Question: Briefly state, in one sentence, what is plotted here.
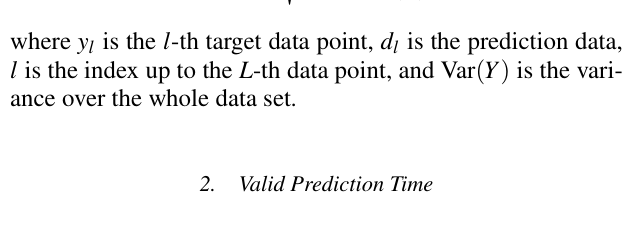
Answer: illustrates the closed-loop feedback configuration. In this setup, after the model has been trained, it is switched to a closed-loop mode, where the model’s own predictions are recursively fed back as input. This method allows for continu- ous predictions, extending beyond the one-step-ahead predic- tion. The quality of predictions in a closed-loop configuration is evaluated by a metric called the valid prediction time (VPT) [28], defined as: